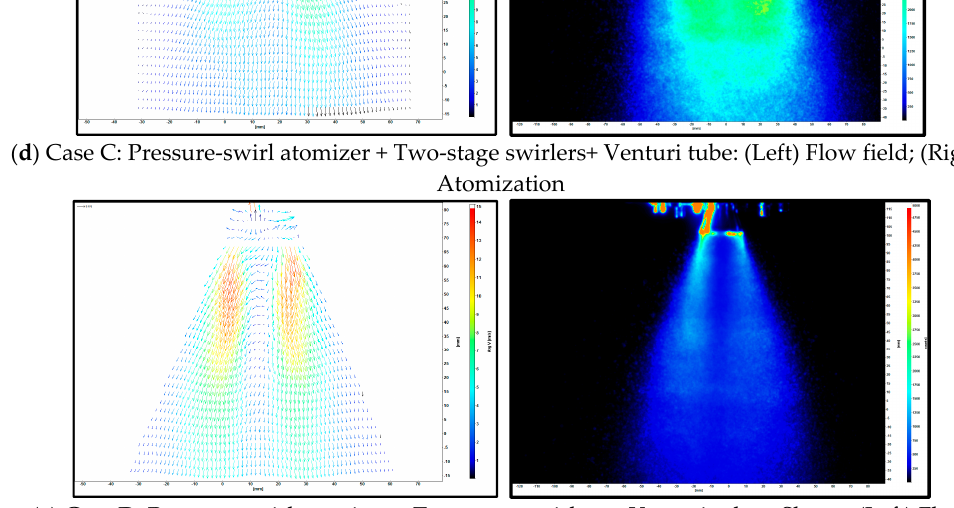
Figure 3. Flow fields and atomization fields of different air-blast atomizer structures (Average results).